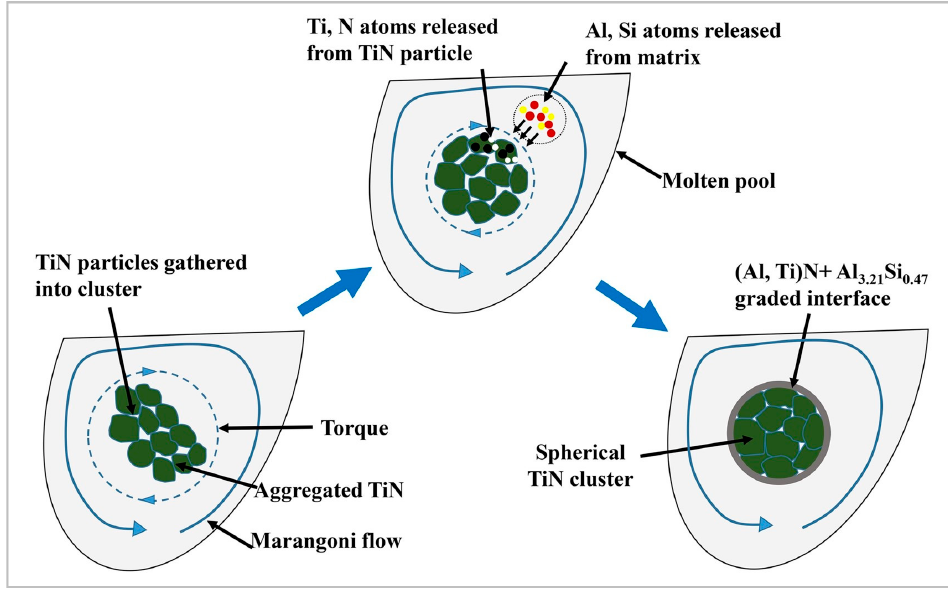
Figure 18. Graphical representation of the movements of aggregated TiN particles and the novel graded layer formation mechanism (reproduced with permission from [100]).